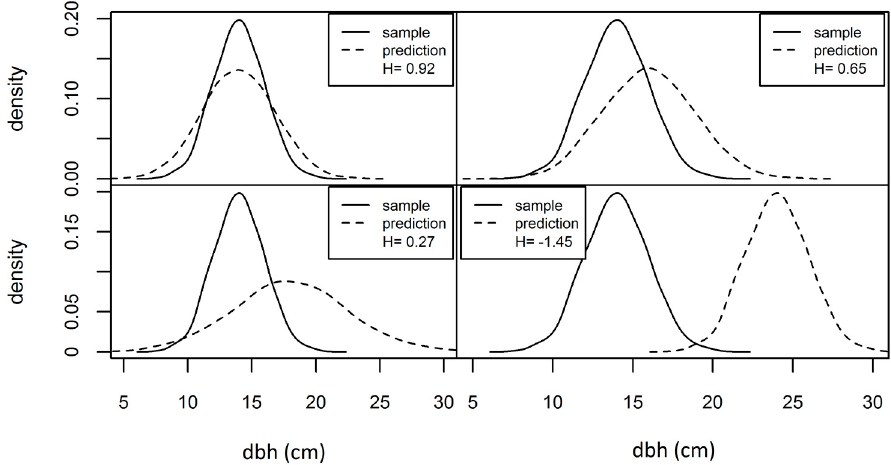
Figure 3. Examples of values of index H for various prediction behaviors.